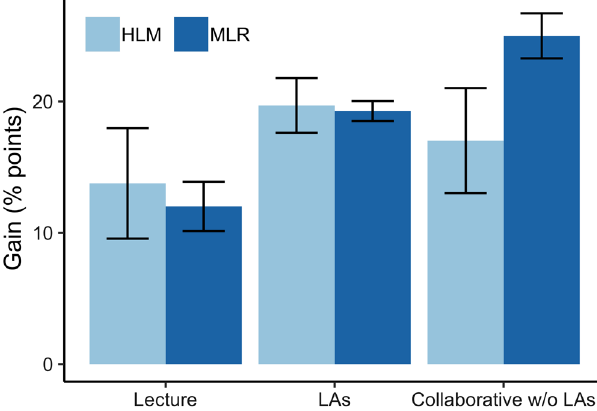
FIG. 4. Predicted gains for average students across course contexts as predicted by HLM and MLR using model 3. Gains were measured as the change in percentage of the questions correct from the pretest to the post-test. Error bars are (cid:5) 1 standard error. Error bars vary in size based on the number and spread of student scores in each course